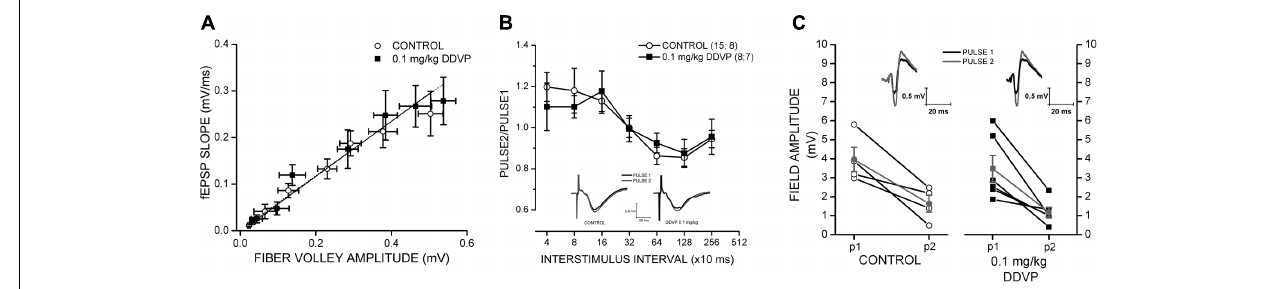
FIGURE 4 | Effect of 0.1 mg/kg DDVP on synaptic plasticity parameters. (A) Effect of DDVP on synaptic efficacy by the measurement of input/output curves obtained from hippocampal tissues of control rats (open circles) and those treated with 0.1 mg/kg DDVP (black squares). The treatment with DDVP did not produce any change in the synaptic efficacy of the Schaffer collateral → CA1 pathway. (B) Interstimulus interval (ISI) curves for hippocampal slices obtained from control (black squares) and DDVP-treated animals (open circles). Paired-pulse facilitation was observed for both conditions at interstimulus intervals below 160 ms. The insets show representative traces of fEPSPs for the control and DDVP-treated animals obtained at a interstimulus interval of 320 ms. Black traces indicate the first pulse (P1) and gray traces indicate the second pulse (P2). (C) Paired-pulse inhibition (PPI) experiments for control conditions (open circles) and DDVP treatment (black squares). The interstimulus interval for these experiments was 13 ms. The PS amplitudes obtained for the first and second pulses are shown. For both conditions, the means of P1 and P2 (gray circles and gray squares for control and DDVP treatment, respectively) are shown. The slopes of the lines connecting the means of P1 and P2 for the two conditions do not show statistical differences. The insets show representative PS traces. Black traces indicate the first pulse (P1) and gray traces indicate the second pulse (P2).